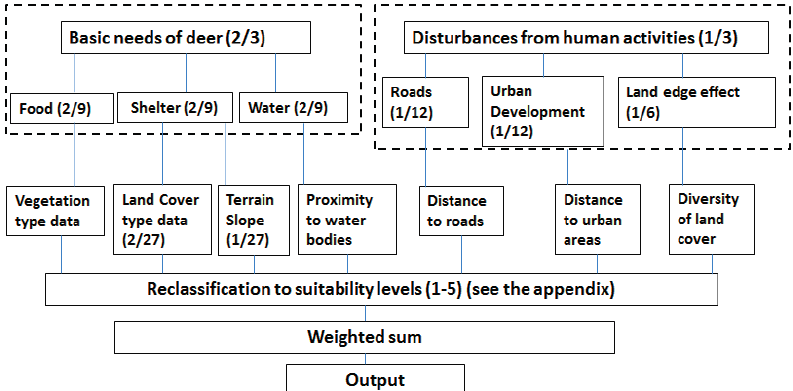
Figure 4. The factors, variables and processing steps used in multi-criteria decision making (MCDM) deer habitat suitability analysis (the numbers in () behind the factors are the weights assigned based on the rank sum